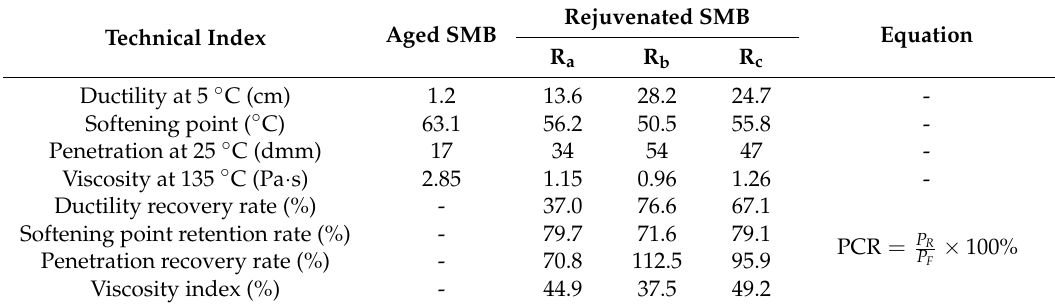
Table 2. Physical properties and recovery rates of aged SMB incorporating rejuvenating systems.